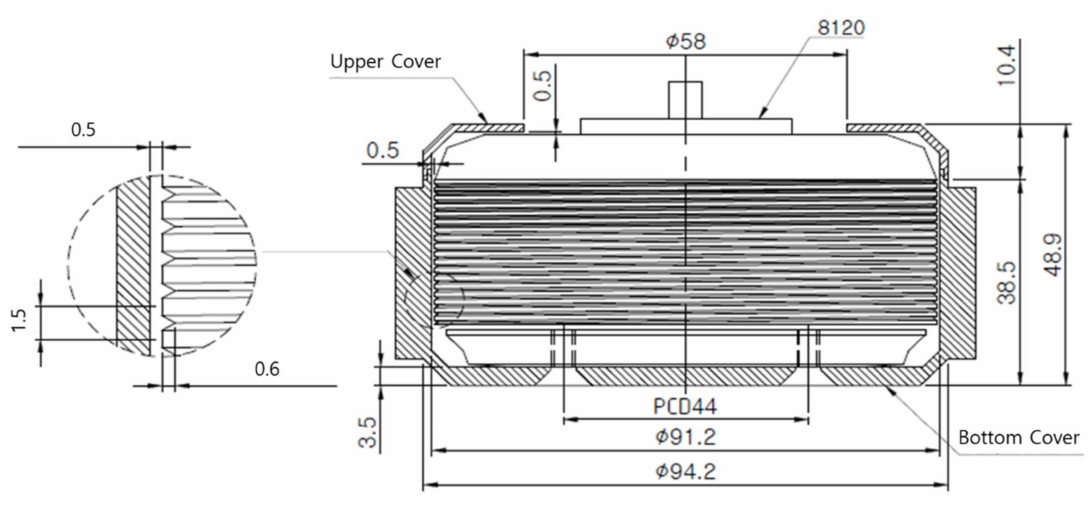
Figure 5. Drawing of the helical-grooved self-cooling case.